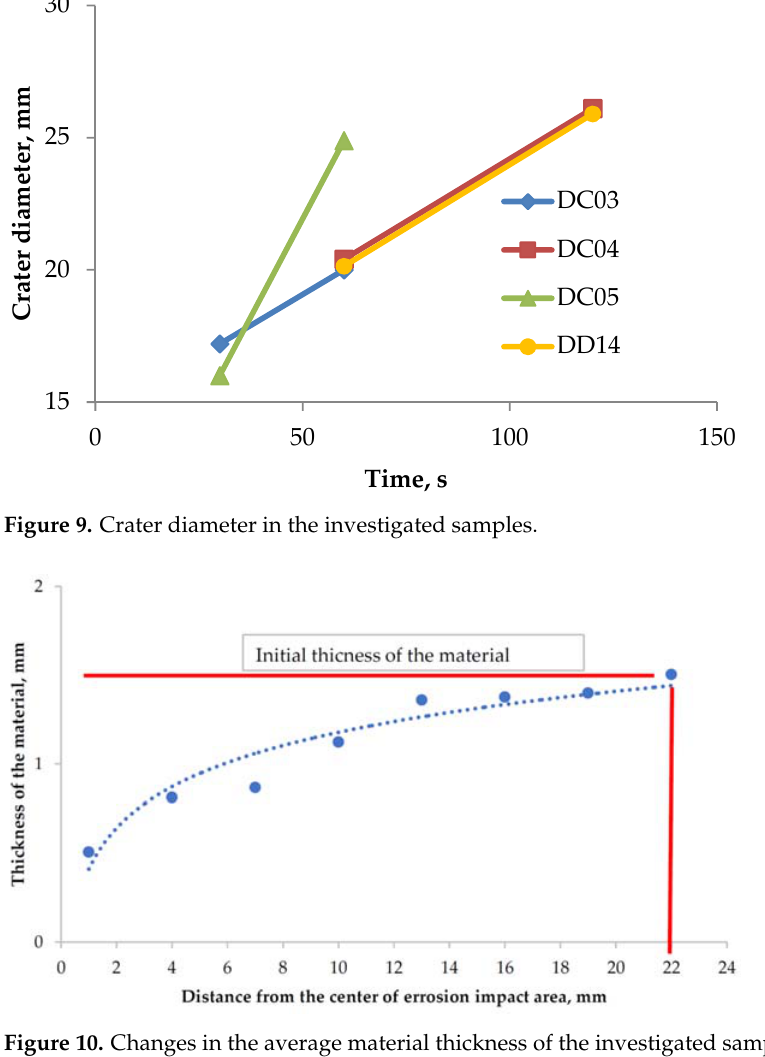
Figure 10. Changes in the average material thickness of the investigated samples.